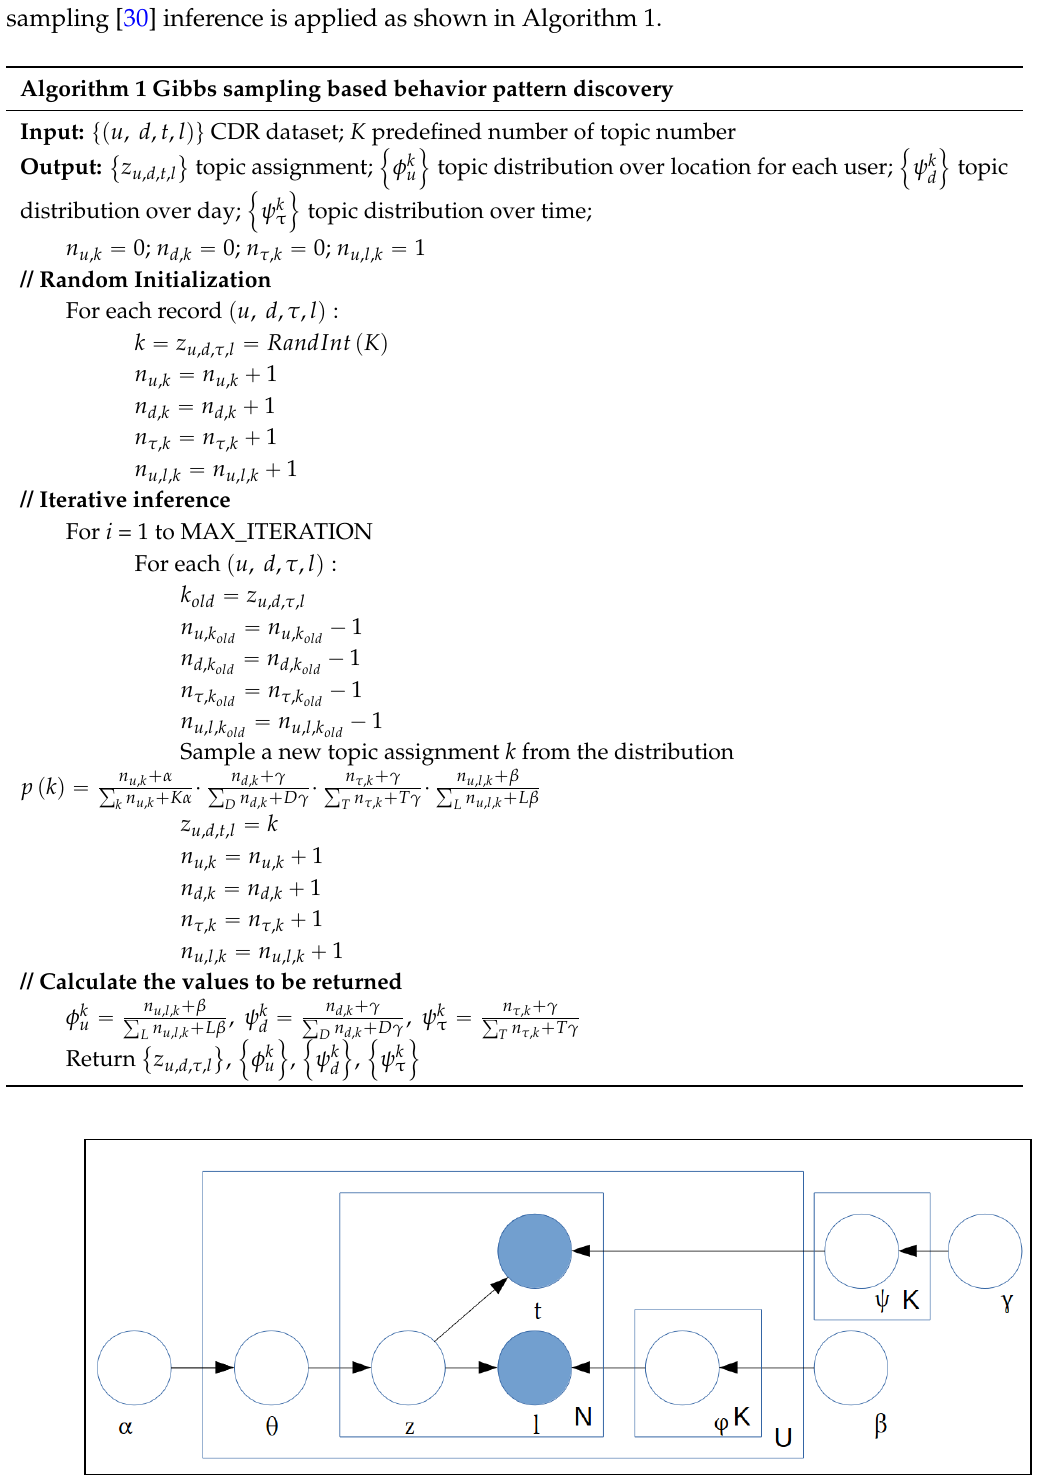
Algorithm 1 Gibbs sampling based behavior pattern discovery